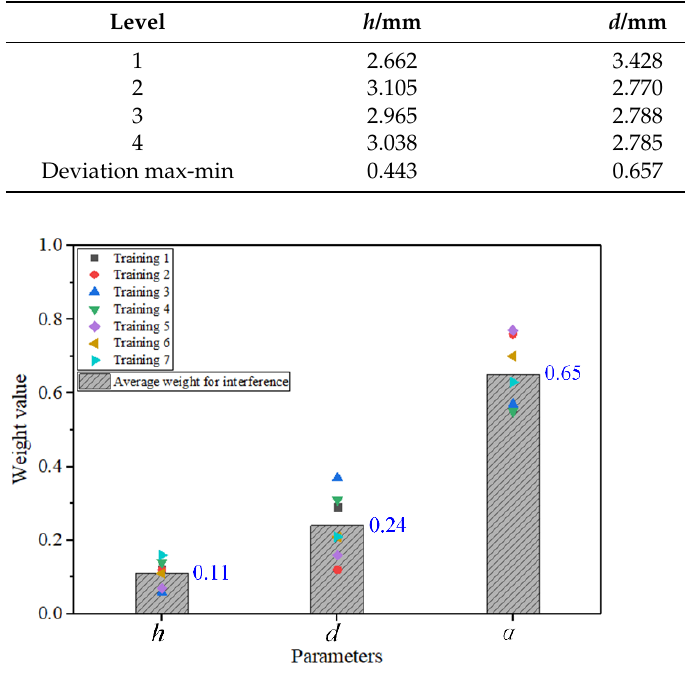
Figure 8. Weight of interference-fit size determined by decision-making